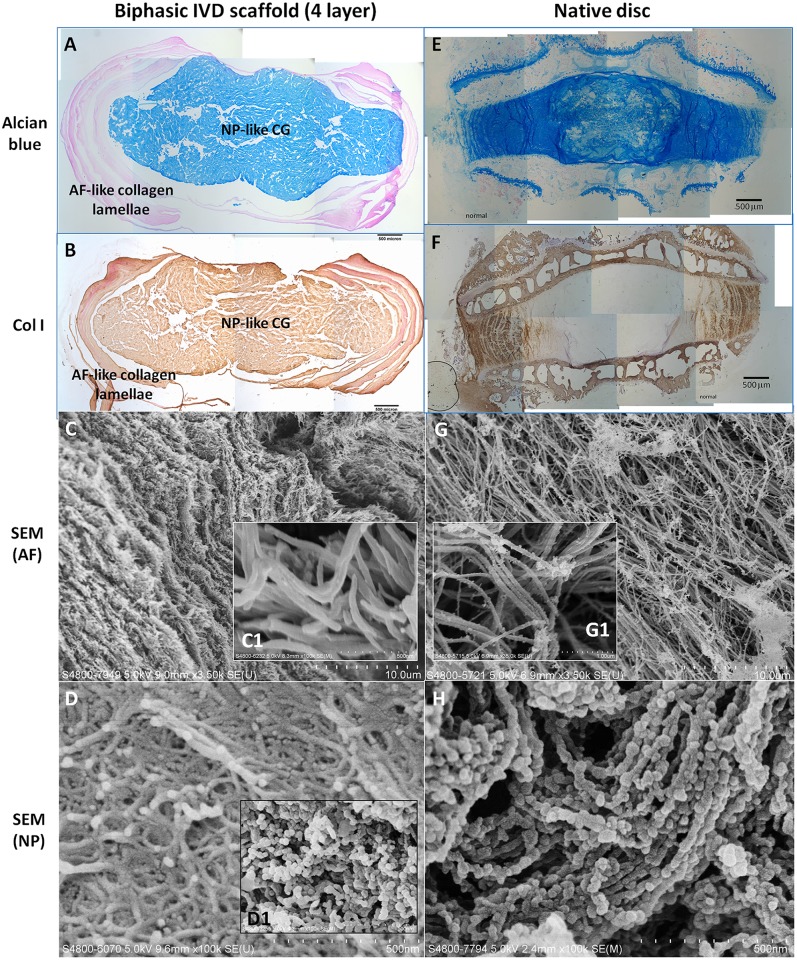
Histomorphometric and ultrastructural characterization of the fabricated biphasic scaffold and native disc.(A-D) Fabricated biphasic scaffold and (E-H) native disc; (A&E) Alcian blue staining and (B&F) immunohistochemistry of type I collagen. (C-D & G&H) SEM images. (C) AF-like collagen lamellae; (D) NP-like core with compaction; (D1) NP-like core without compaction; (G) AF lamellae in the native disc; (H) NP core in the native disc. Scale bars are 500 μm (for A-B & E-F); 10 μm (for C&G); 1 μm (for G1) and 500 nm (for D-D1&H).